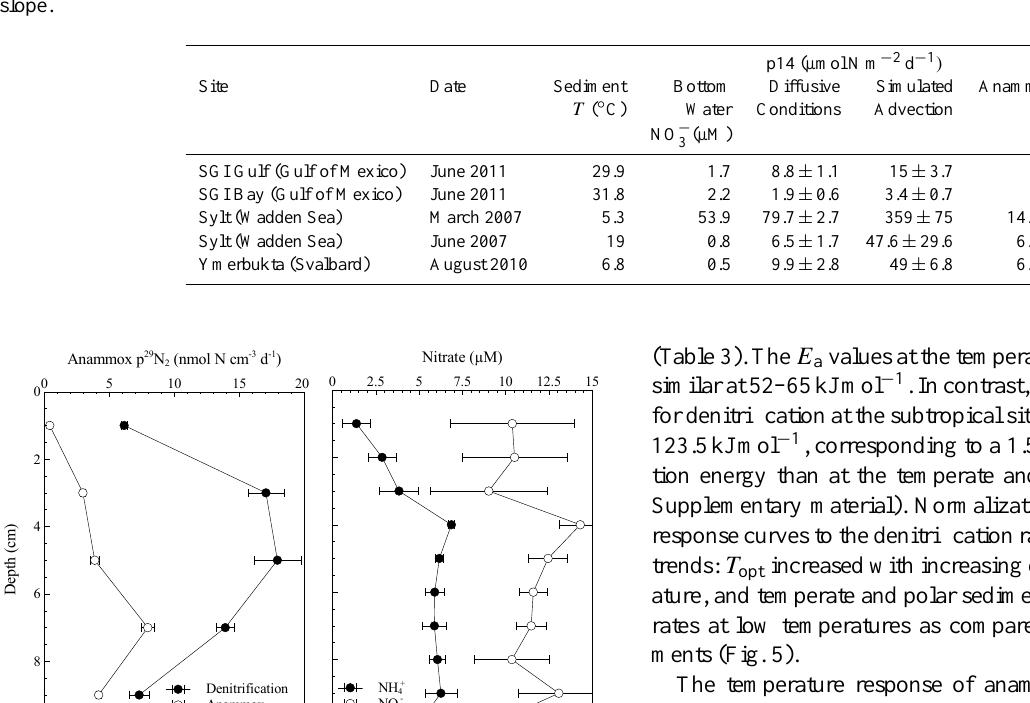
Table 2. Isotope pairing technique (IPT) rate measurements of denitrification and anammox. The production of unlabeled N 2 (p14) was calculated according to Risgaard-Petersen et al. (2004), and the contribution of anammox (% Anammox) was determined in anaerobic slurries according to Thamdrup and Dalsgaard (2002). Error estimates for p14 were determined from the standard error of the regression slope.